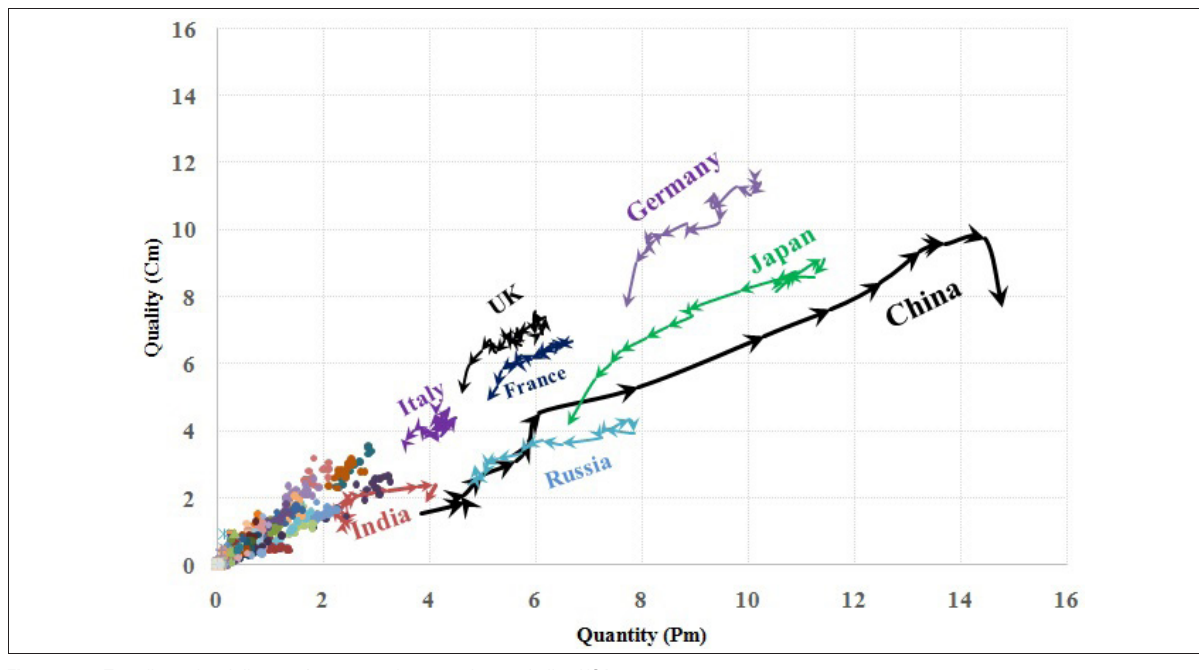
Figure 4: Two-dimensional diagram for most active countries, excluding USA.